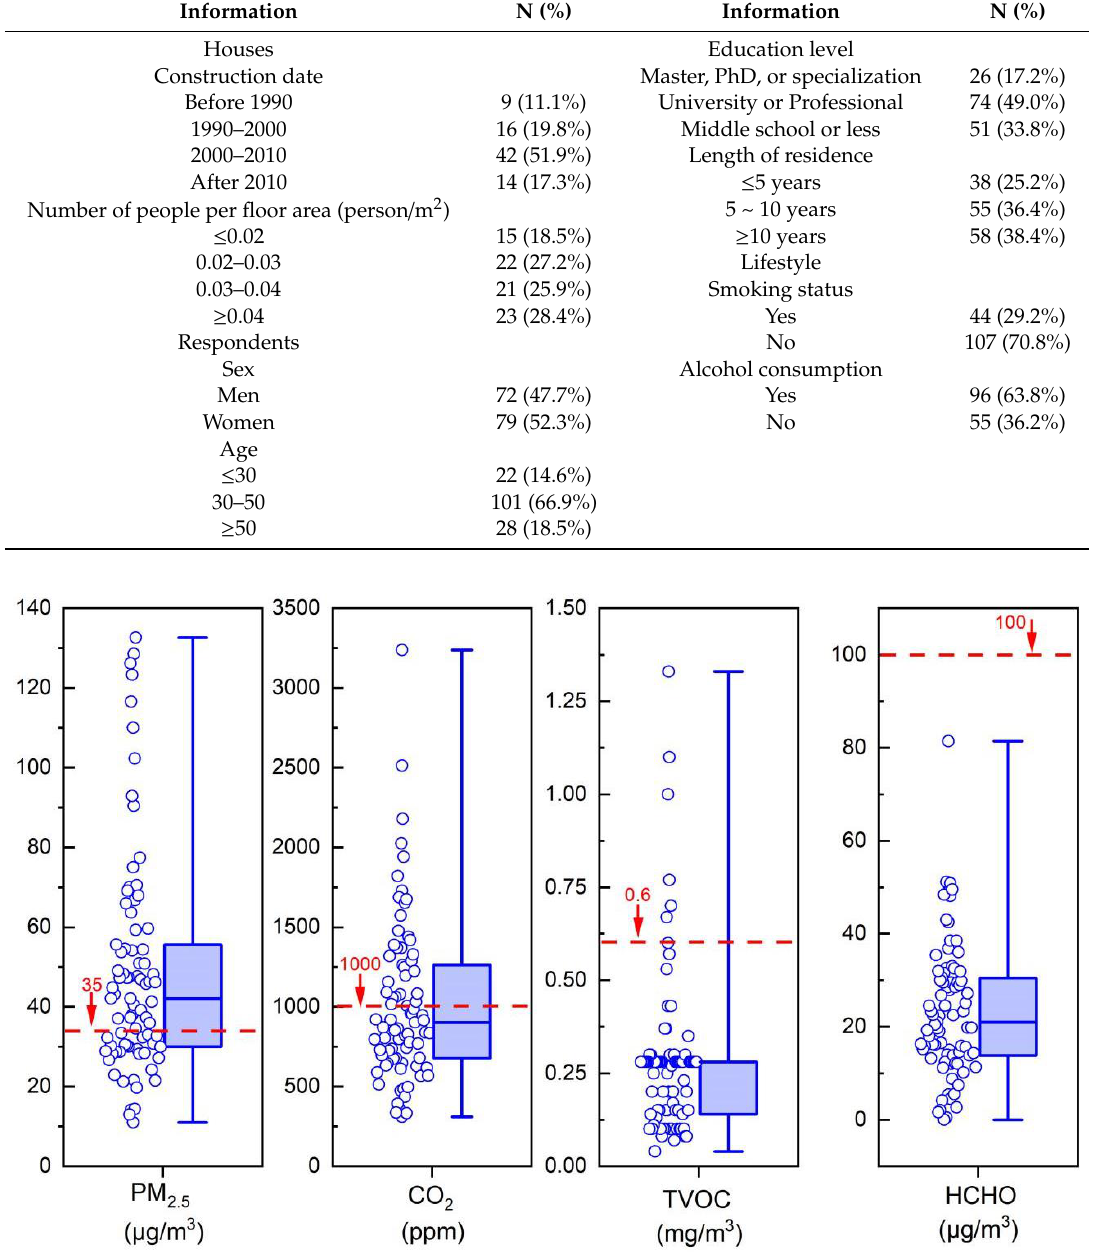
Figure 3. Distribution of the average values of indoor environmental parameters. Boxplots show medians, 25 ~ 75percentiles (box) and min-max (whiskers). The red dash lines indicate the standard value recommended by the National Indoor Air Quality Standard